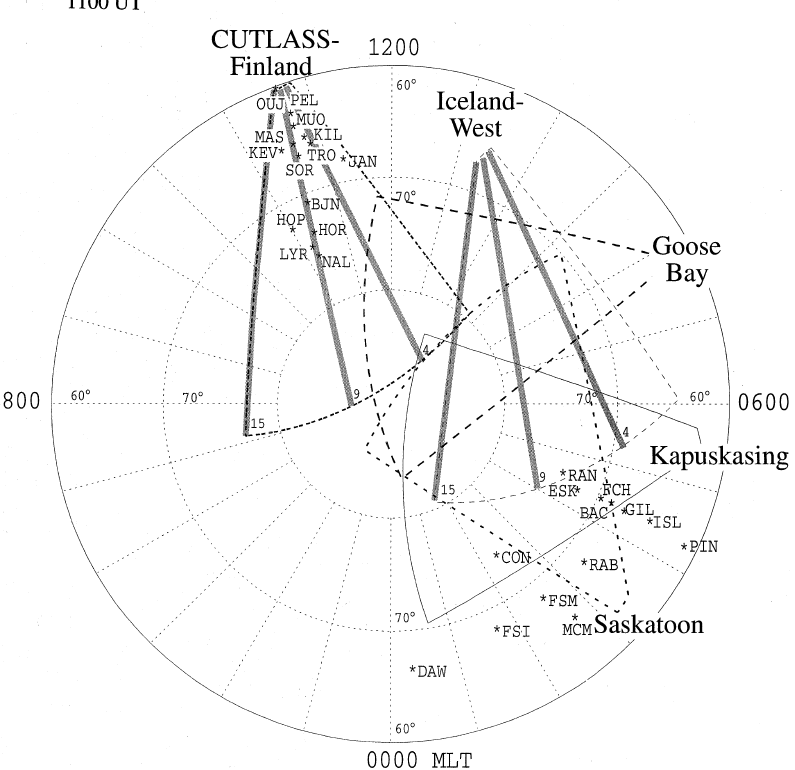
Fig. 1. Polar map illustrating the fields-of-view of the five SuperDARN radars employed in this study. The map is in AACGM latitude and local time coordinates corresponding to 1100 UT. The CUTLASS-Finland and Iceland-West beams from which data are presented in Fig. 5 are represented by thick grey lines . Also included in the figure are the locations of the magnetometer stations of the IMAGE and CANOPUS chains, data from which have been used in